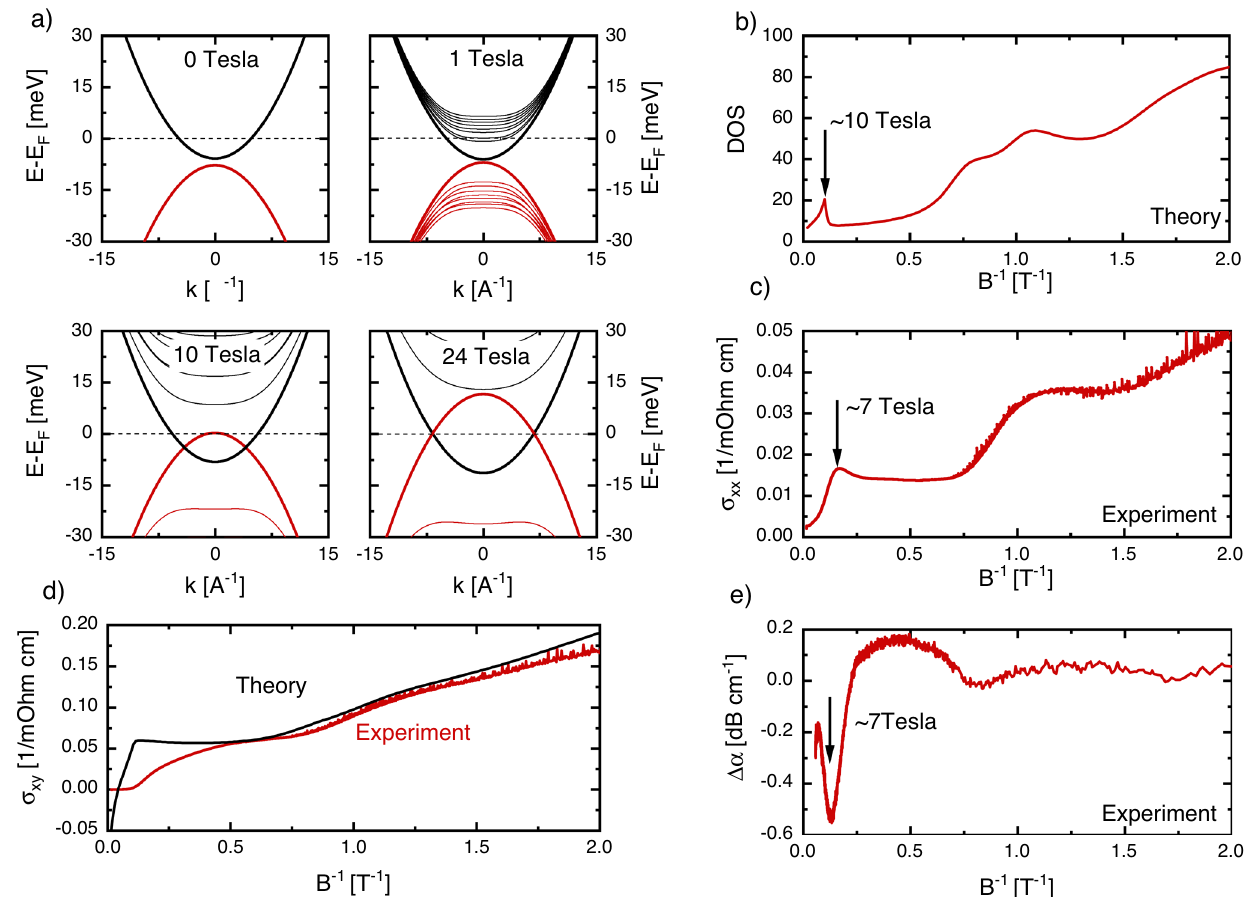
Fig. 2 | Field-induced Lifshitztransition in ZrTe5.a FielddependenceofLandau- level dispersions with fi eld applied along the b- axis. b Calculated density of states for the proposed model (see ‘ Methods ’ section for the parameters